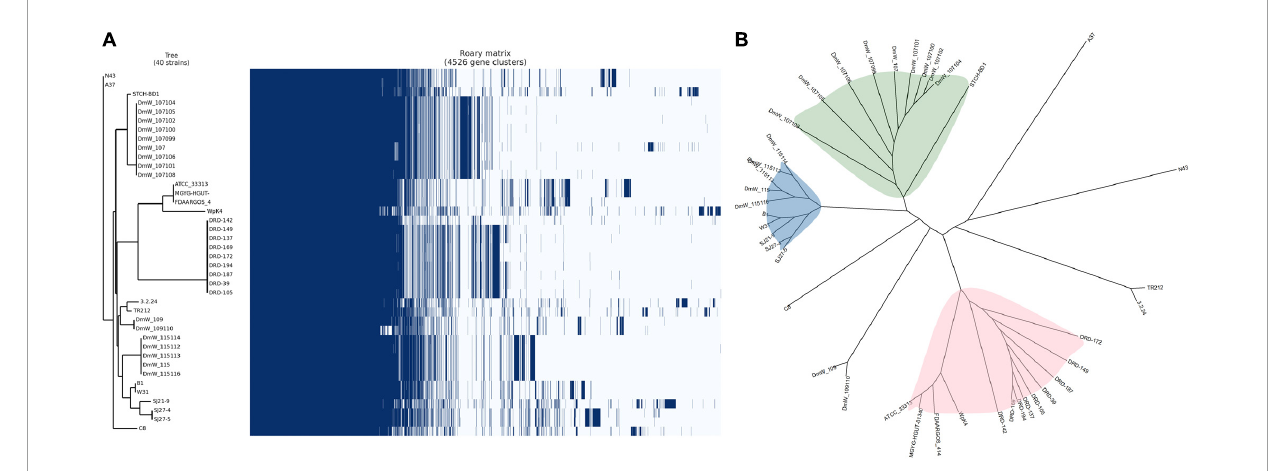
origin of isolation, which also is reflected the relatedness of SJ21- 9 strain to